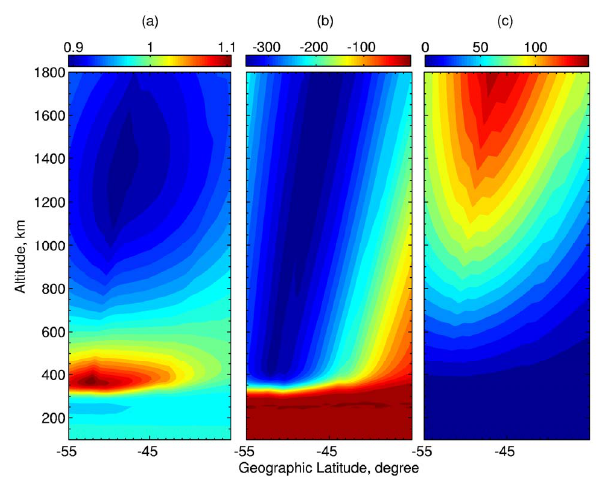
Fig. 7. Same as Fig. 4, but for the conjugate hemisphere (35 ◦ S– 55 ◦